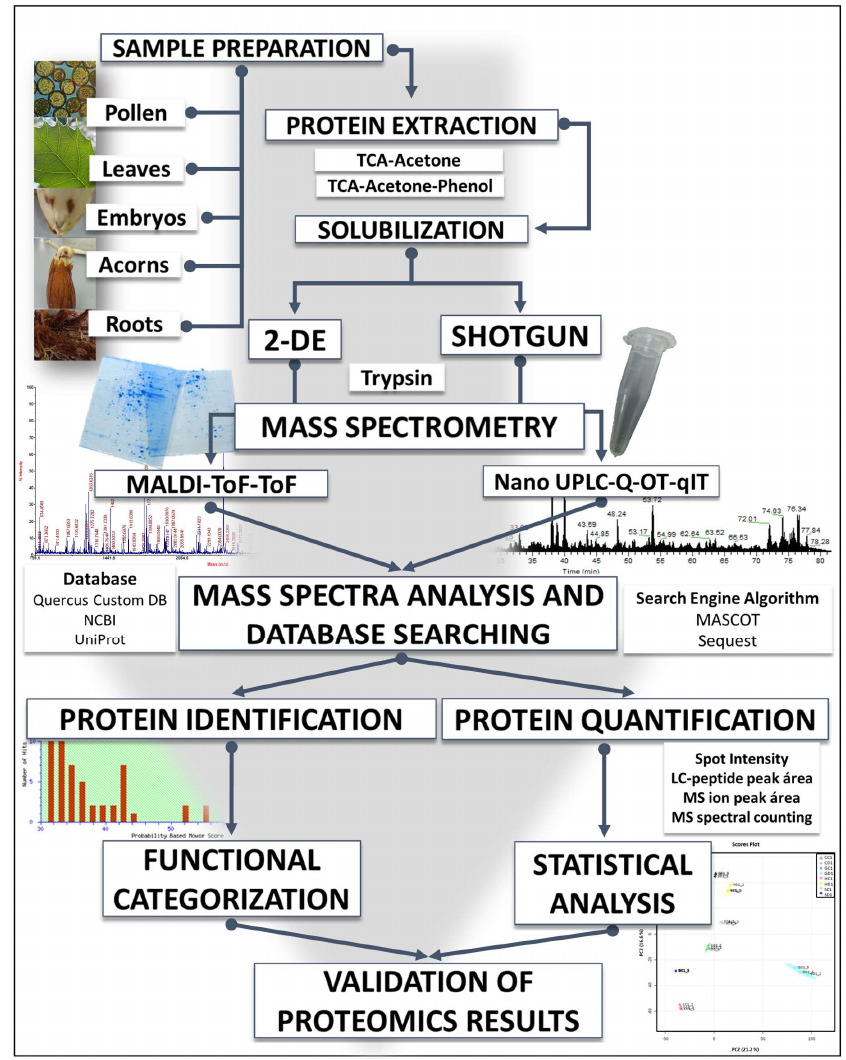
Figure 1. Workflow of a proteomics experiment, from sample preparation to data analysis and validation. It includes alternative, complementary approaches or strategies, based on MS analysis of proteins (top-down) or tryptic peptides (bottom-up), either gel-based or gel-free. LC: liquid chromatography; MS: mass spectrometry.